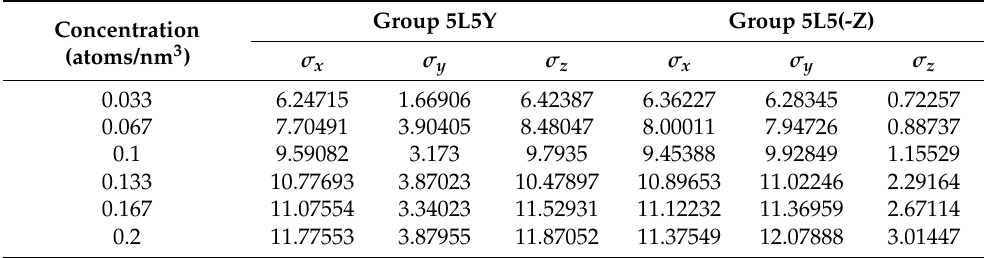
Table 3. The variance of the stress components at the velocity is 20 ˚A/ps.